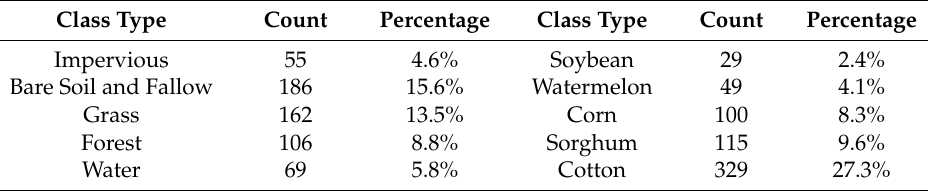
Table 3. Count and percentage by class type for 1200 reference